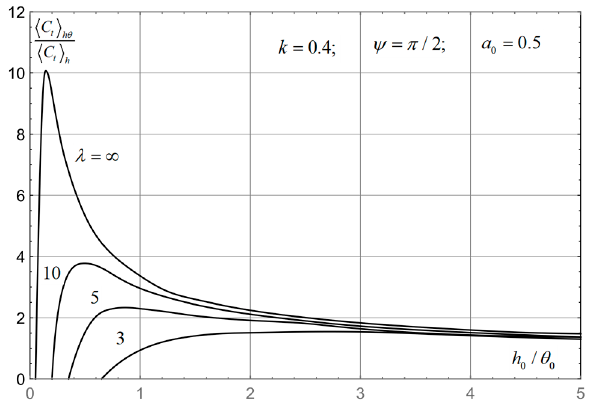
. Figure 16. Ratio of period-averaged thrust coefficient for combined heave–pitch oscillations to that of purely heave oscillations versus amplitude ratio for different phase shift,